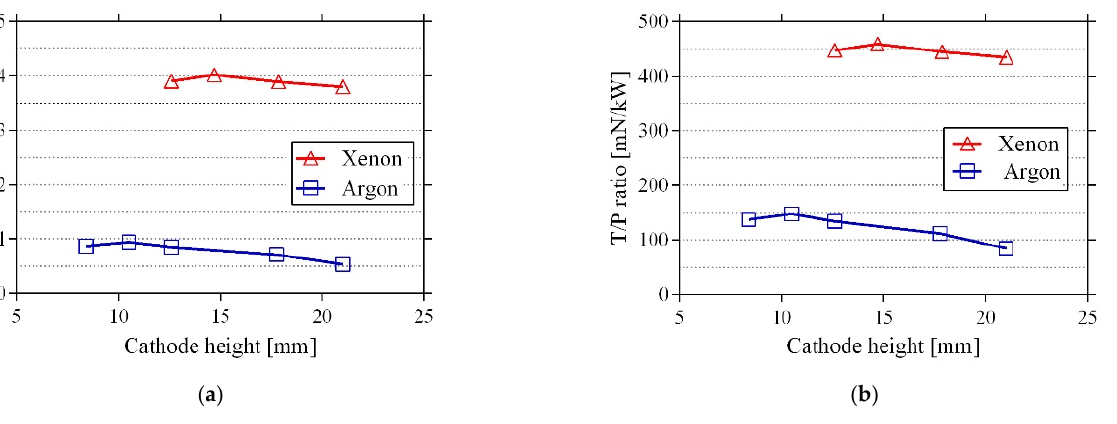
Figure 4. Influence of the cylindrical height in the thruster’s performance at 20 kV: ( a ) variation of the output thrust T in ( µ N) for several heights (mm); ( b ) variation of the thrust-to-power ratio T / P in (mN/kW) for several radius (mm).